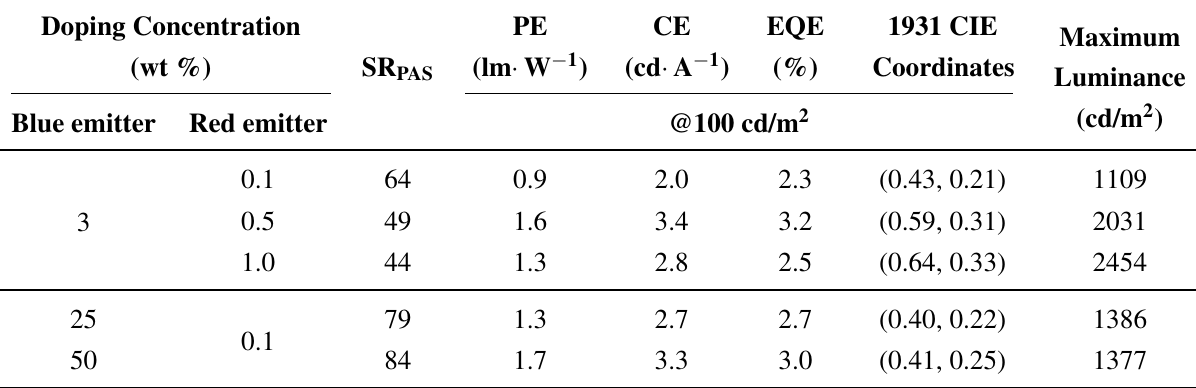
Figure 1. Schematic illustration of the photosynthetic action spectrum-mimicking OLED device that is composed of a single solution-processable emissive layer with a sky-blue emitter and a red emitter dispersed in a host and their molecular structures. Notably, emission tuning from light- to deep-blue can be done by simply varying the doping concentration of the sky-blue emitter. Table 1. Effects of doping concentration of the blue and red emitters on the photosynthetic action spectrum resemblance (SR PAS ), power efficiency (PE), current efficiency (CE), external quantum efficiency (EQE), and the CIE coordinates of the PAS-mimicking OLED devices studied.